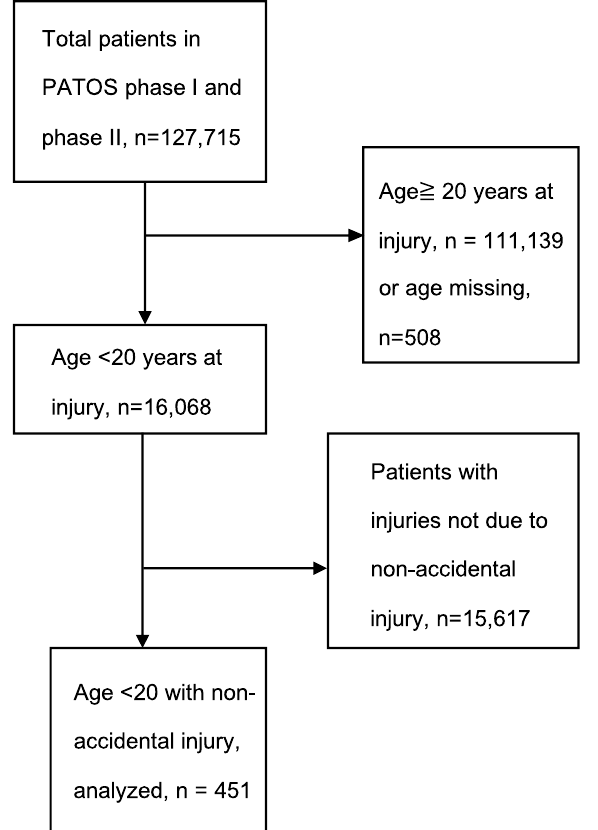
Figure 1. Study algorithm of patients included in the study. PATOS Pan-Asian Trauma Outcome Study.